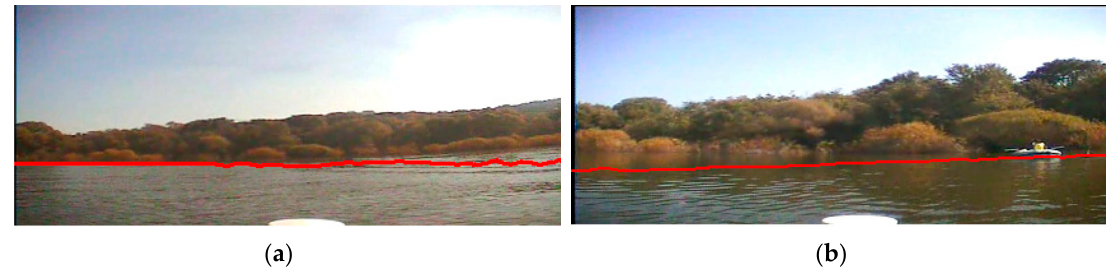
Figure 21. Waterline detection result without our preprocessing stage. ( a ) The detection result when there is a brightness layer; ( b ) The detection result when there is a shade.